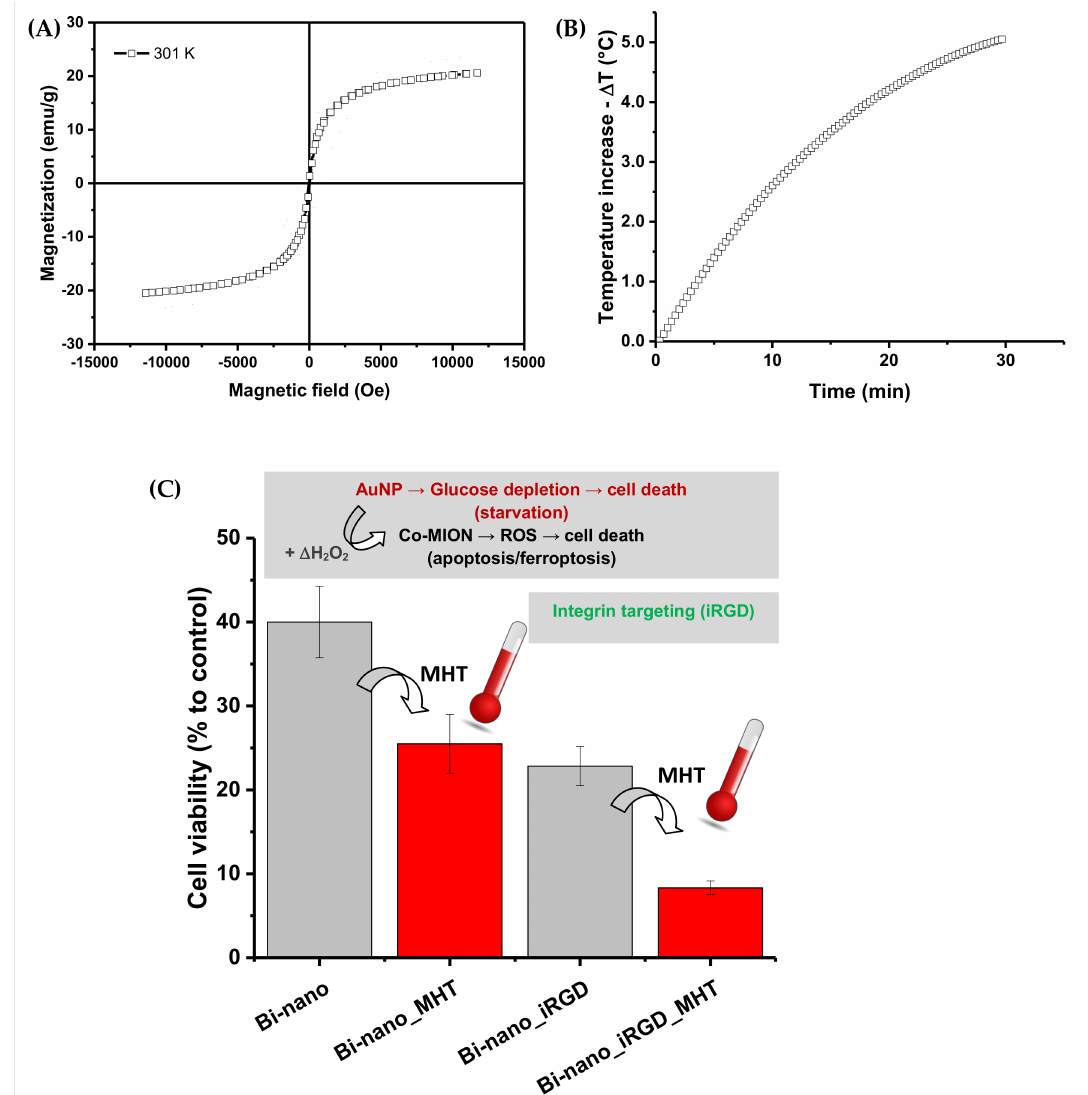
Figure 10. ( A ) Magnetization versus magnetic field at room temperature (300 K). ( B ) Heating curve in- duced by magnetic hyperthermia experiments ( ∆ T = 5.2 ◦ C) associated with Co-MION@CMC nanoparti- cles. ( C ) Cell viability response of U87 brain cancer cells after incubation with Bi-nano and Bi-nano_iRGD for evaluation of the combined effects of magnetic hyperthermal therapy and chemodynamic biocat- alytic therapy (+ Control: 10.3 ± 1.4 %; - Control: 98.8 ± 2.5 %; -Control + MHT: >